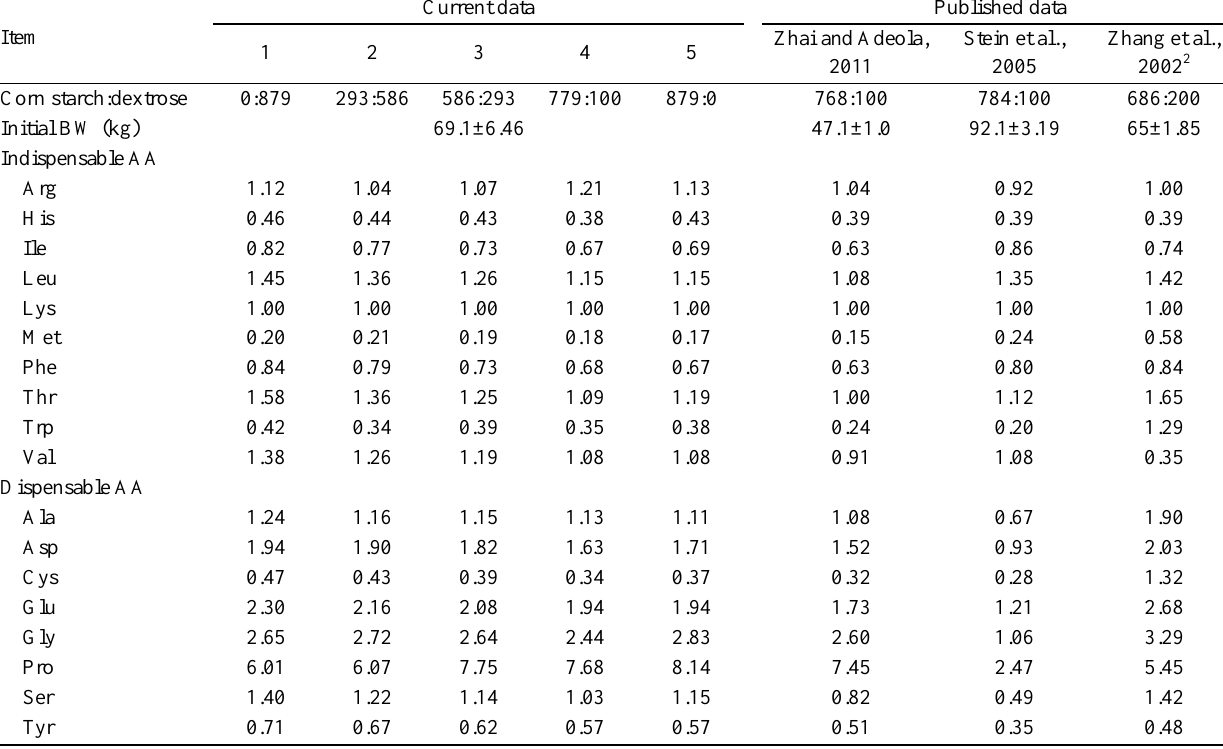
Table 4. Ratio of individual AA to lysine in ileal endogenous flow of pigs fed N-free diets with different proportions of corn starch and dextrose